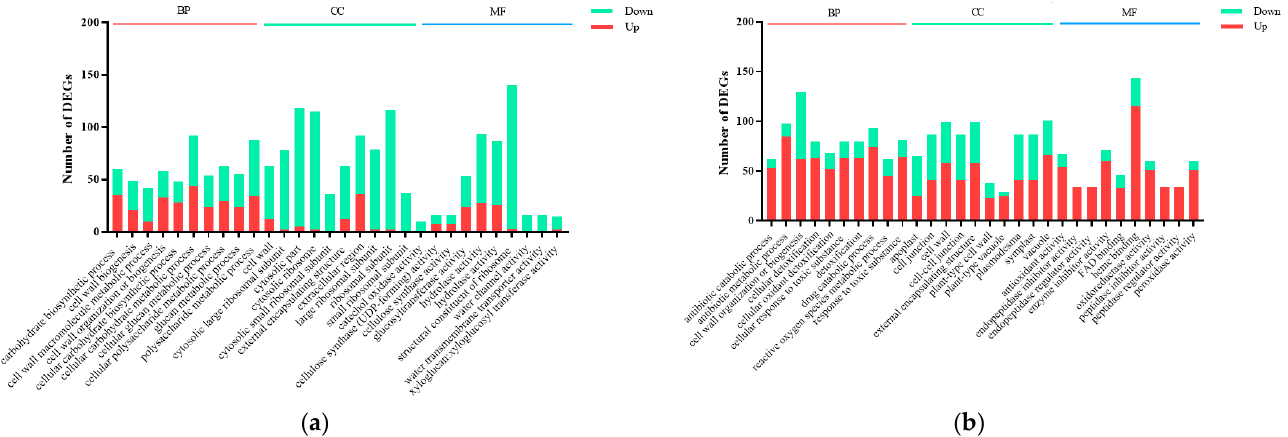
Figure 4. The number of differentially expressed genes (DEGs) in the shoots ( a ) and roots ( b ) of poplars fertilized with Gln compared with the inorganic N control. Red bars indicate numbers of upregulated genes; green bars indicate numbers of downregulated genes.